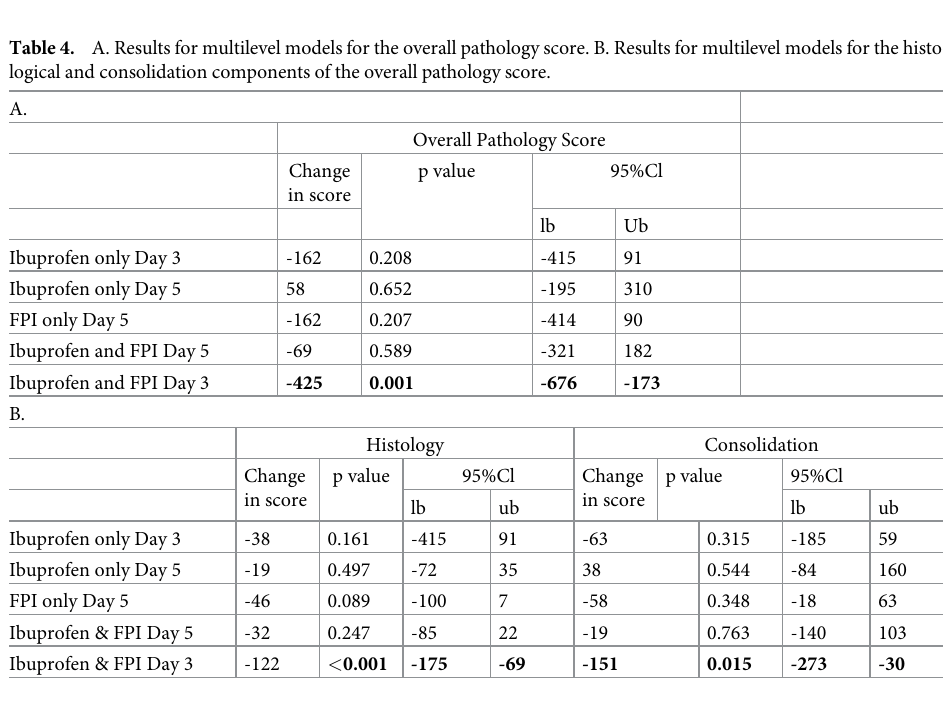
Placebo is referent. Cl; confidence interval, lb; lower bound, ub upper bound.